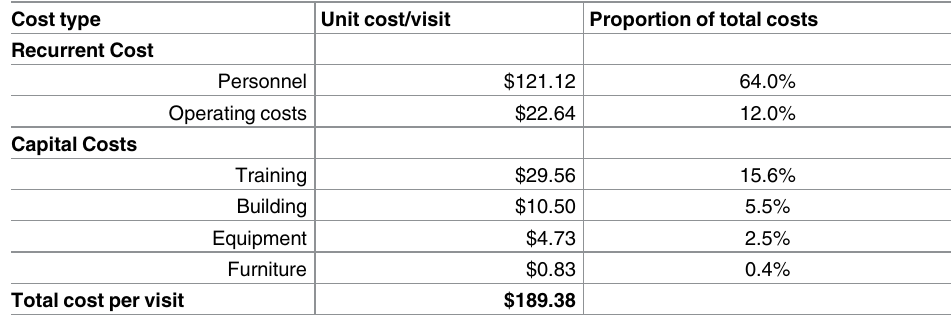
Table 3. Breakdown of provider costs in 2013